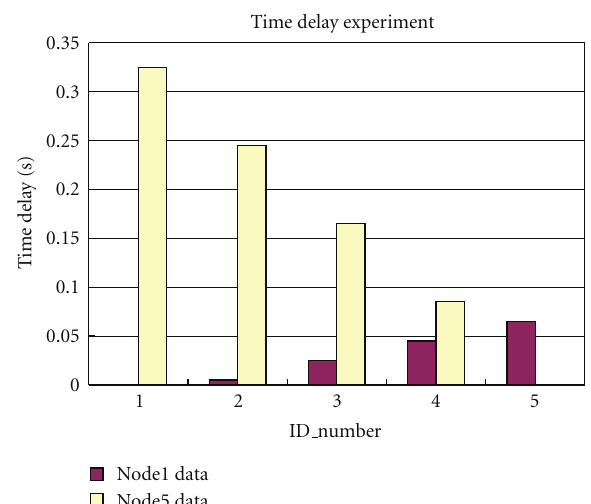
Figure 22: Experiment result of four-hop